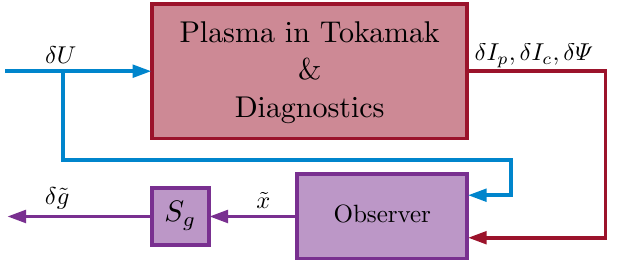
Figure 5. Robust observer synthesized via LMIs for use in a real experiment. The red vector signal includes experimental signals obtained by the magnetic diagnostic system. The blue vector signal includes voltages on the poloidal coils. The yellow signal contains states estimation, which includes gaps